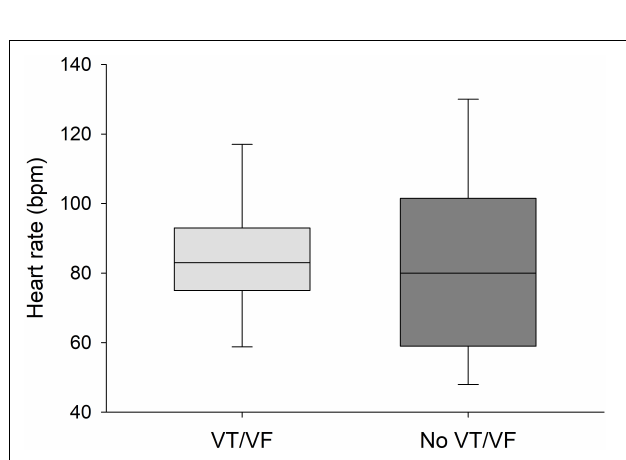
FIGURE 4 | No significant differences were found in heart rate between patients that developed VT/VF after first ECG-recording and patients that remained in sinus rhythm. Solid line: Median, box-plot: 25- to 75-persentile, and error bars: 5- and